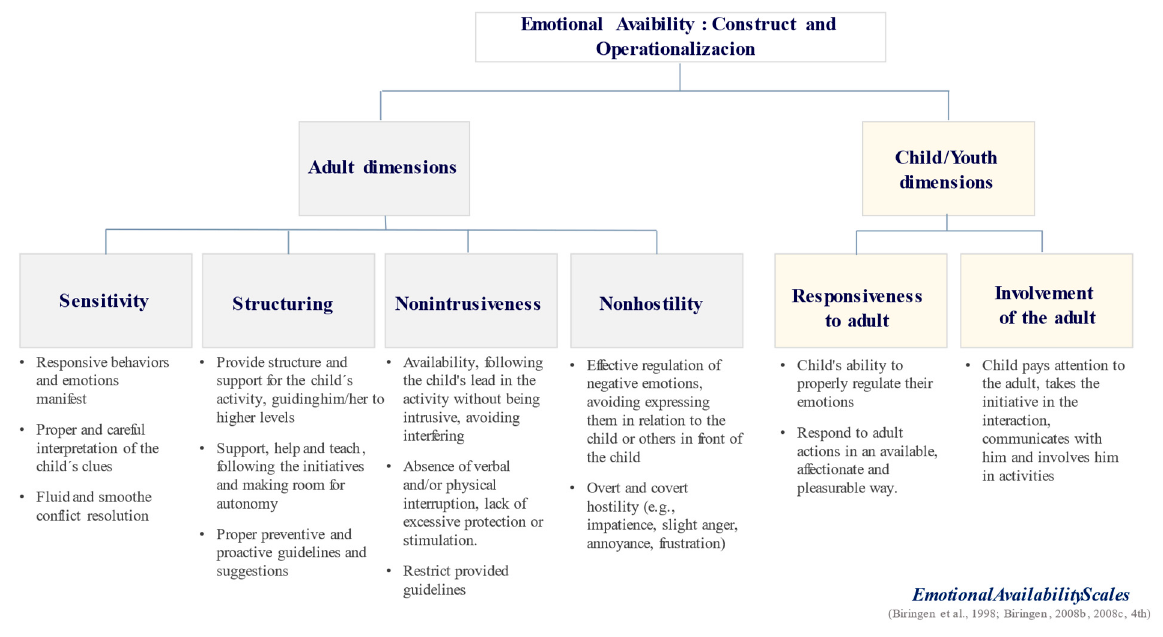
Figure 1. Dimensions of emotional availability (EA).